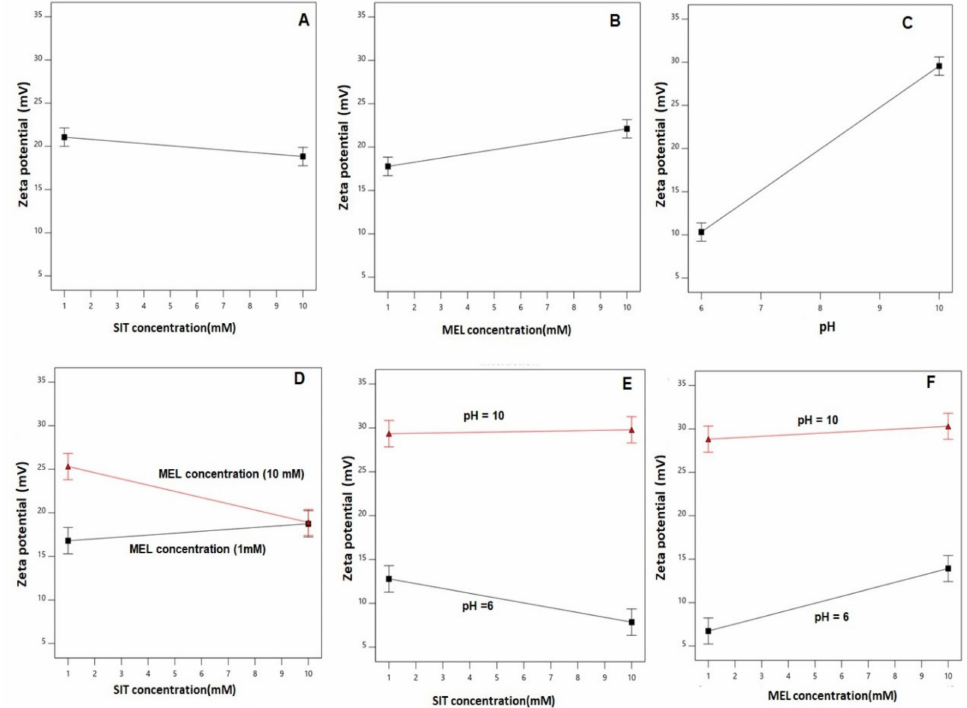
Figure 3. Main effects ( A – C ) and interactions ( D – F ) of SIT concentration (X 1 ), MEL concentration (X 2 ), and pH (X 3 ) on zeta potential of SIT-MEL nano-sized